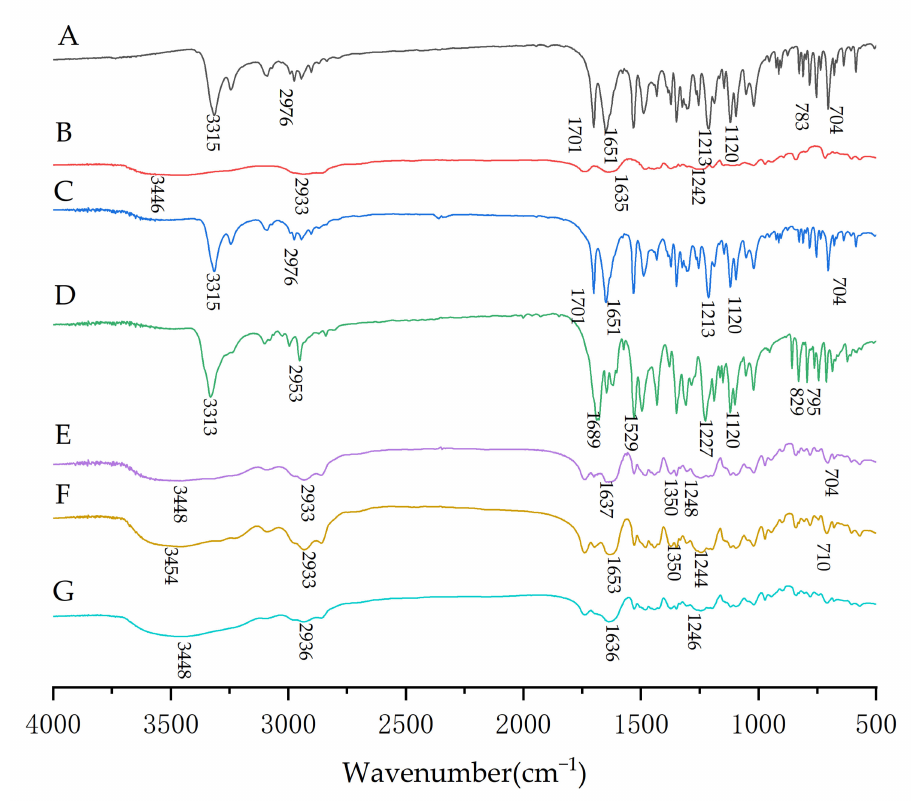
Figure 11. FTIR spectra of samples including NIT ( A ), Soluplus ® ( B ), NIT PM ( C ), NIT AM ( D ), saSMSD/ NIT NC FQC ( E ), saSMSD/ NIT NC CP ( F ), saSMSD/ NIT C HME ( G